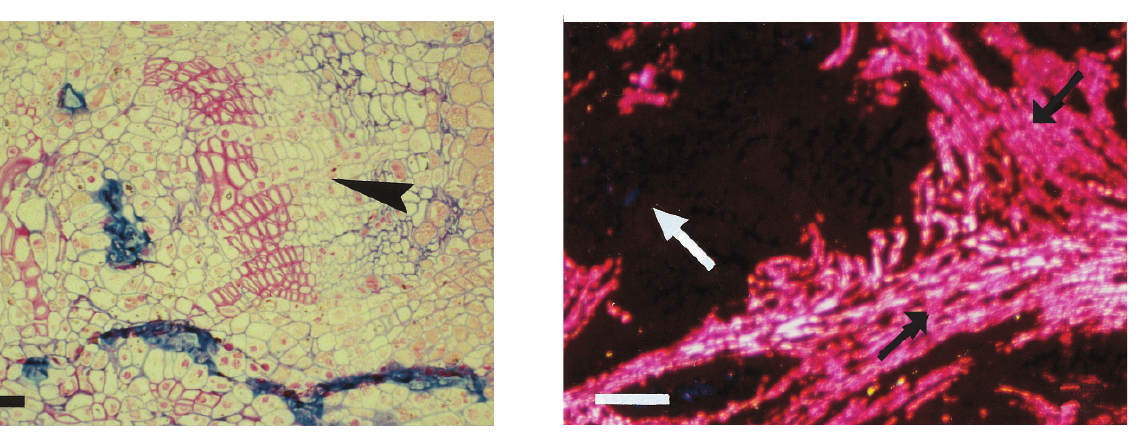
Fig. 8. Cross-section of an Aleppo pine twig with a deep knot. The disorganisation of the second-year wood ring (arrow head), the presence of bacteria and the interrup- tion in the 3rd xylem ring (arrows) are clearly visible. Bar=500 μ m (fuchsin-Astra blue).